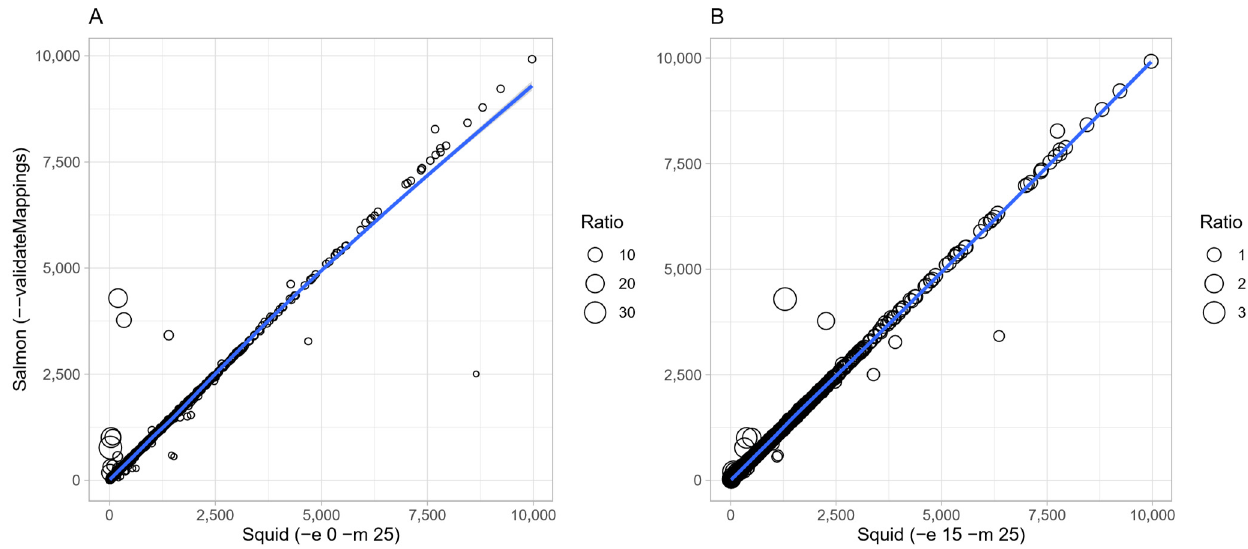
Figure 2. Scatterplot of transcripts quantification . Each circle represents the raw counts of a gene in Salmon ( y axis) and Squid ( x axis). Squid was run using exhaustiveness 0 ( A ) and 15 ( B ), respectively. Per-gene ratio was calculated dividing Salmon’s raw counts by Squid’s raw counts (extracted from the BEDPE output file). Note how the ratio scale is different by an order of magnitude between ( A ) and ( B ), indicating that mapping accuracy is affected when no additional cycles are performed. Coefficients of determination were 0.97 and 0.99 in ( A ) and ( B ), respectively. The regression line was calculated using the generalized additive model (GAM) through the R package